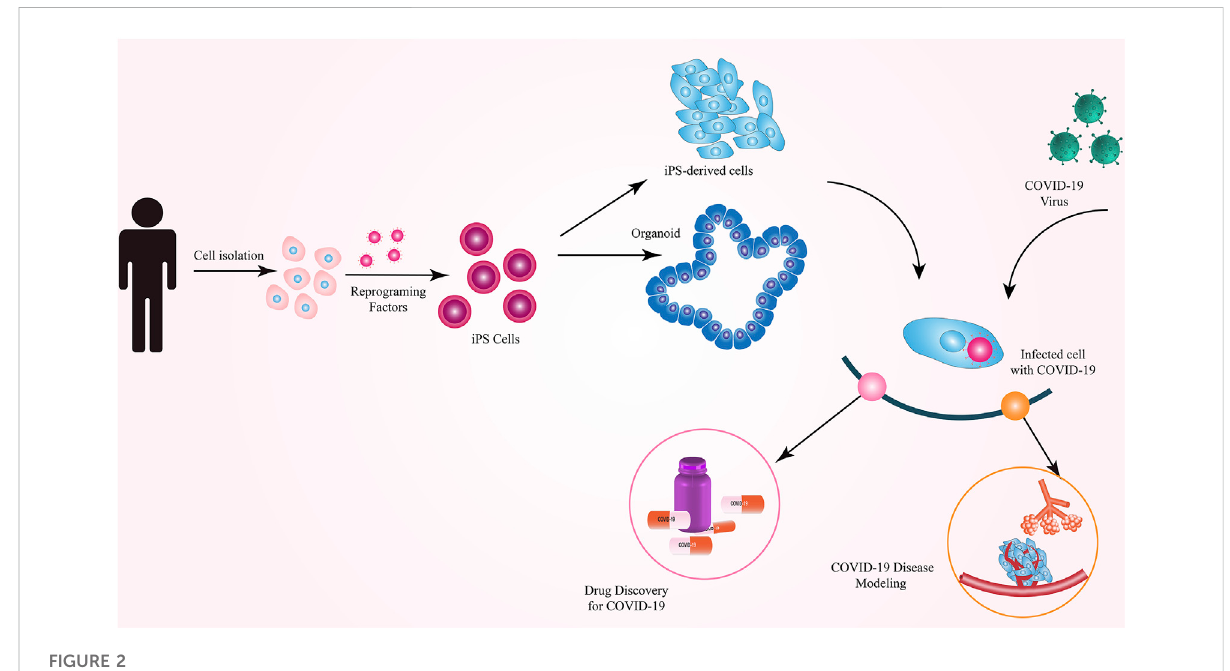
FIGURE 2 Applications of iPSCs in COVID-19